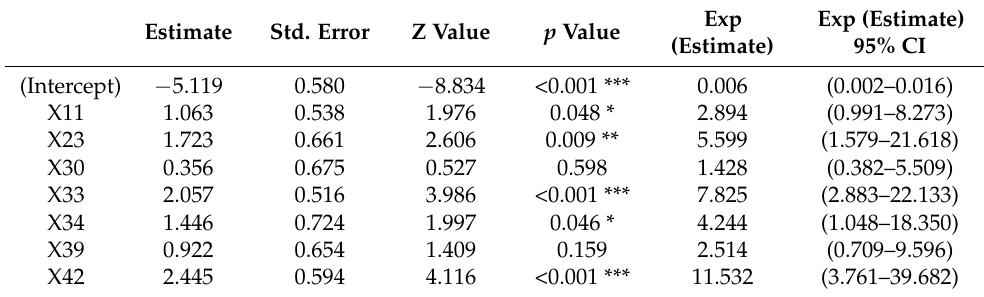
Table 3. Model of all independent variables.